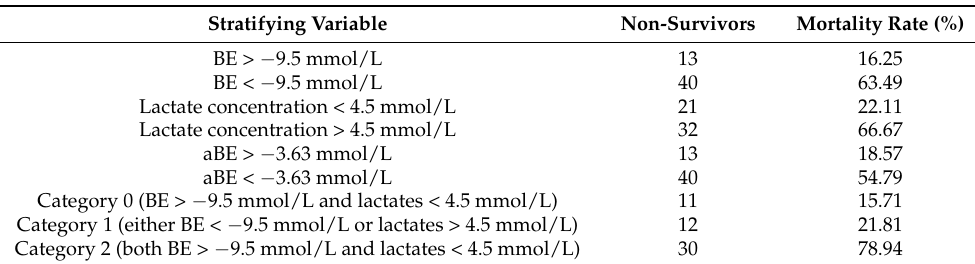
Table 2. The mortality rate in specific subgroups of patients stratified to cut-off values of BE; lactate concentration; alactic BE; or categories 0, 1, and 2 based on combined cut-offs of BE and lactate concentration.